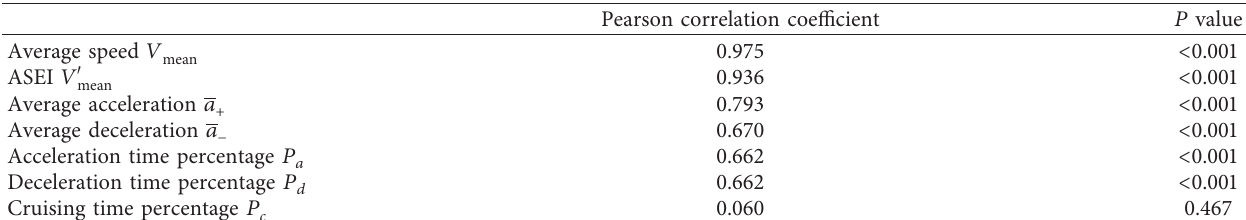
Table 3: Correlation analysis of driving behavior collected from OBD and mobile phone